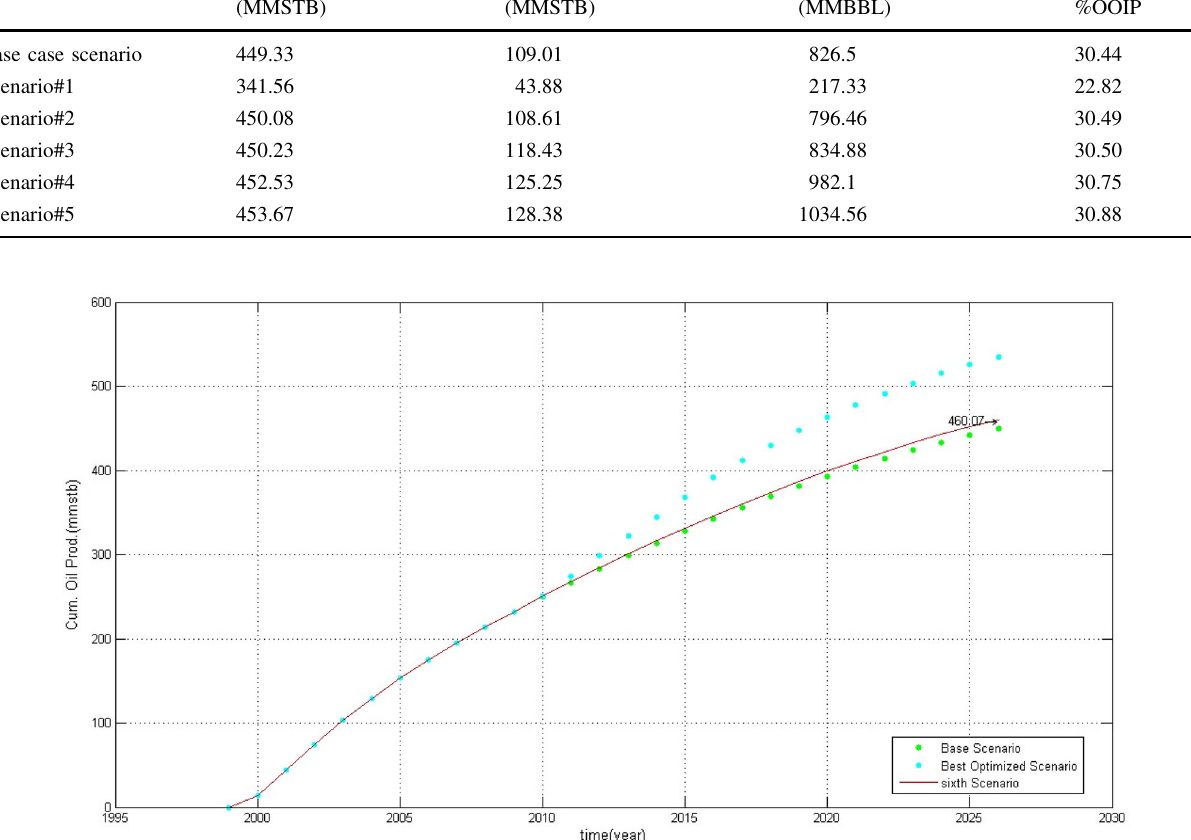
Fig. 12 Cumulative oil production of sixth